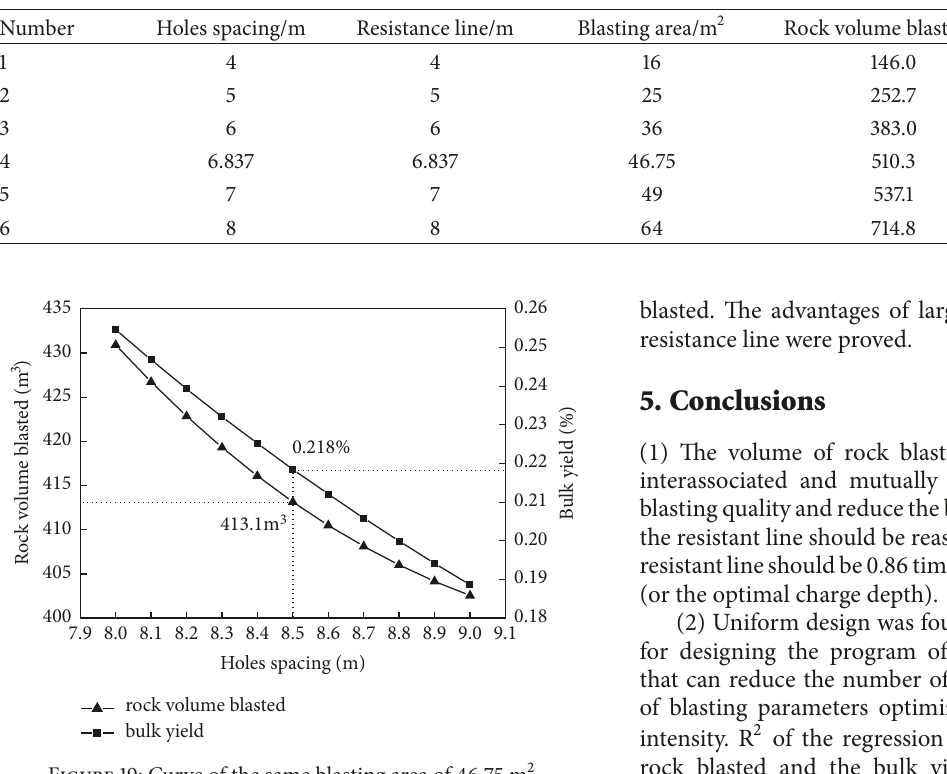
Figure 19: Curve of the same blasting area of 46.75 m 2 .